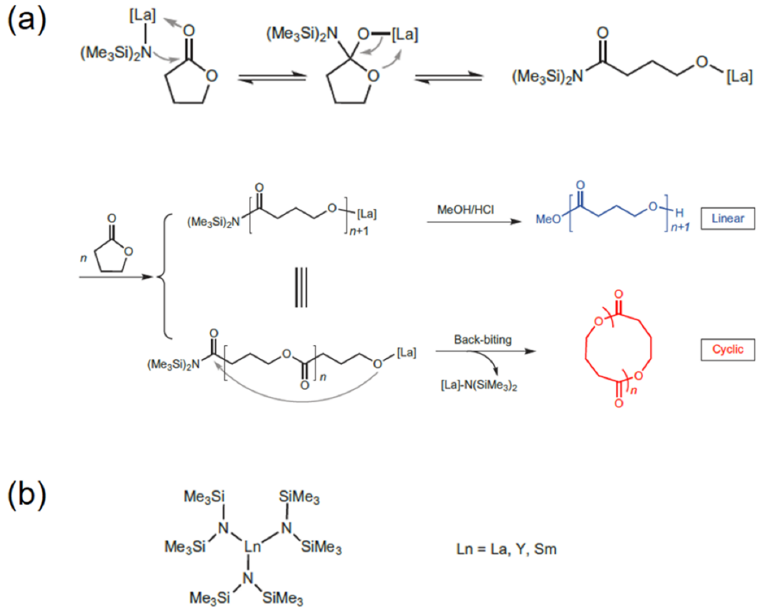
Figure 2. Reversible polymerization in ring-opening polymerization systems. ( a ) Proposed mechanism for lanthanide-catalyzed ROP of γ -BL in the preparation of both linear and cyclic P γ BL; ( b ) Chemical structure of lanthanide catalyst. Reproduced with permission from [68] .